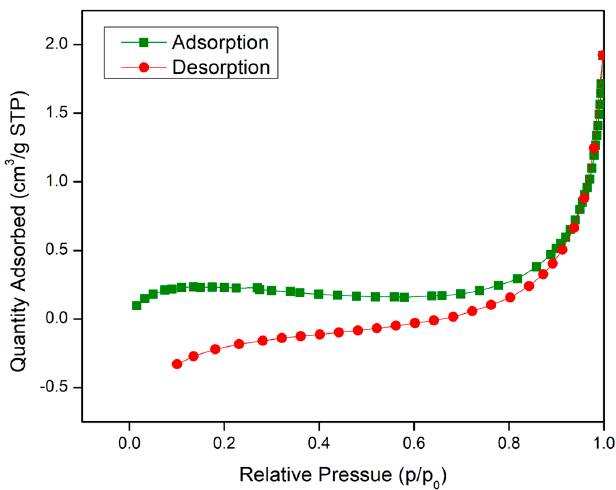
Figure 9. Nitrogen adsorption–desorption isotherms curves for IL@UiO −